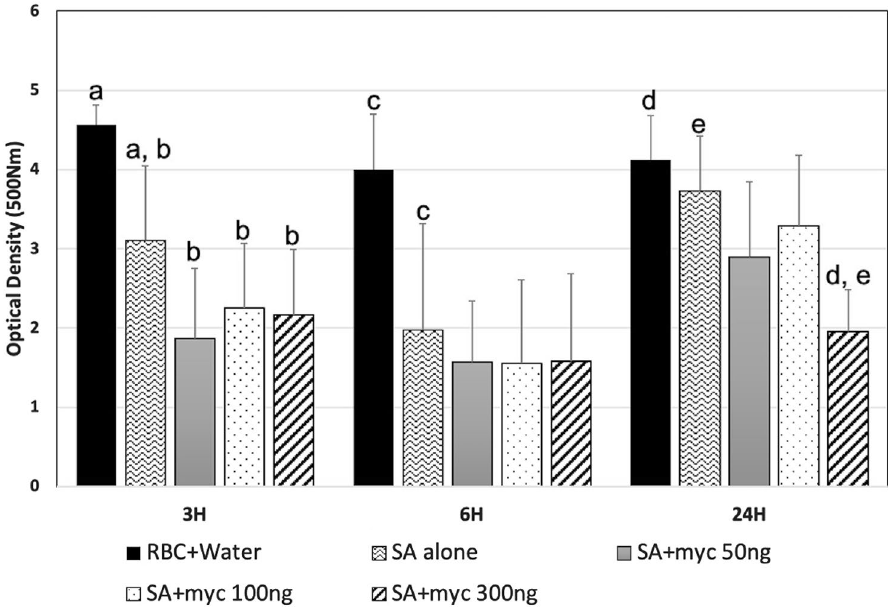
Figure 2. Mycolactone co-Incubation reduced S. aureus hemolysis over time. Graph showing OD500 of red blood cells incubated with water (positive control), S. aureus alone, S. aureus plus 50 ng mycolactone, S. aureus plus 100 ng mycolactone, or S. aureus plus 300 ng mycolactone. Significance was determined as < 0.05. (a–c), and (d,e) denotes significantly different treatments at 3H, 6H, or 24H,